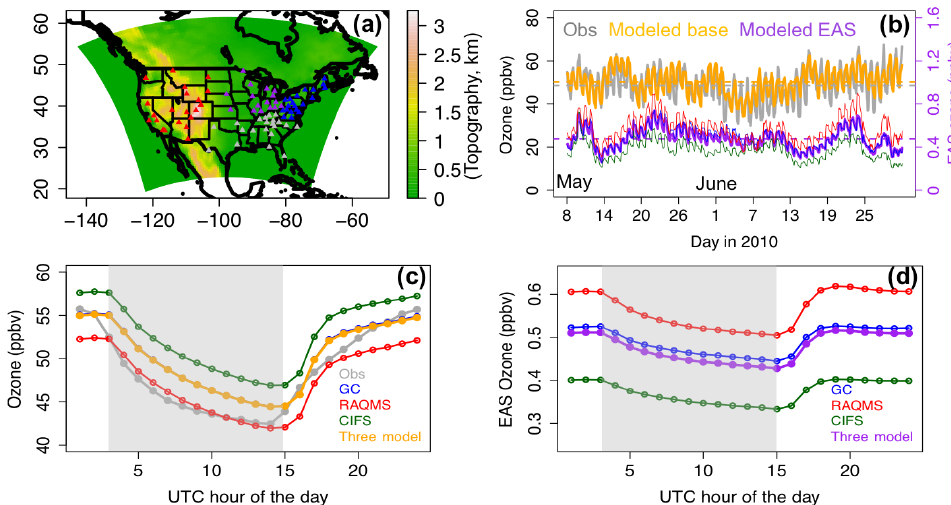
Figure 2. (a) The 60km STEM NAM domain, colored by the model topography. The CASTNET sites to evaluate O 3 from the STEM base simulations are marked as triangles in different colors that identify the subregions they belong to (red: western US; gray: southern US; purple: the Midwest; blue: northeastern US). (b) Evaluation of the STEM-modeled (averaged from the three base simulations using the GEOS-Chem, ECMWF C-IFS, and RAQMS base runs as the chemical boundary conditions) hourly O 3 at the western US (i.e., EPA regions 8, 9, and 10) CASTNET sites. Observations, modeled base O 3 , and the modeled R (O 3 , EAS, 20%) are in gray, orange, and purple lines, respectively. The horizontal dashed lines indicate the period-mean values. The R (O 3 , EAS, 20%) values from STEM calculations using three different chemical boundary conditions are shown separately in thin lines (blue: GEOS-Chem; red: RAQMS; green: C-IFS). The period-mean diurnal variability of the STEM-modeled (c) base and (d) R (O 3 , EAS, 20%) at the western US CASTNET sites. The STEM calculations using three different chemical boundary conditions are shown separately as well as averagely. Light gray-shaded areas indicate the local standard nighttime (from 06:00/07:00p.m. to